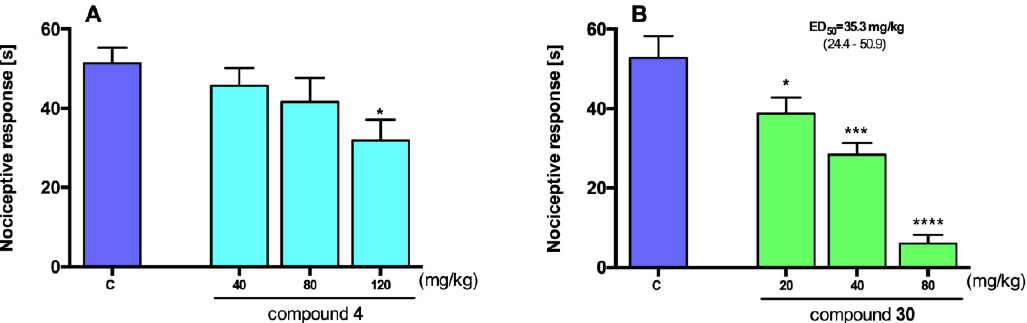
Figure 3. Antinociceptive activity of compounds 4 ( A ) and 30 ( B ) in the capsaicin test. Results are shown as time of licking in the period of 5 min after intraplantar injection of capsaicin. Each value represents the mean ± SEM for 8–10 animals. Statistical analysis: one-way ANOVA followed by post hoc Dunnett’s test. Statistical significance compared to vehicle-treated animals (Tween): * p < 0.05, *** p < 0.00, **** p < 0.0001. C—control group.